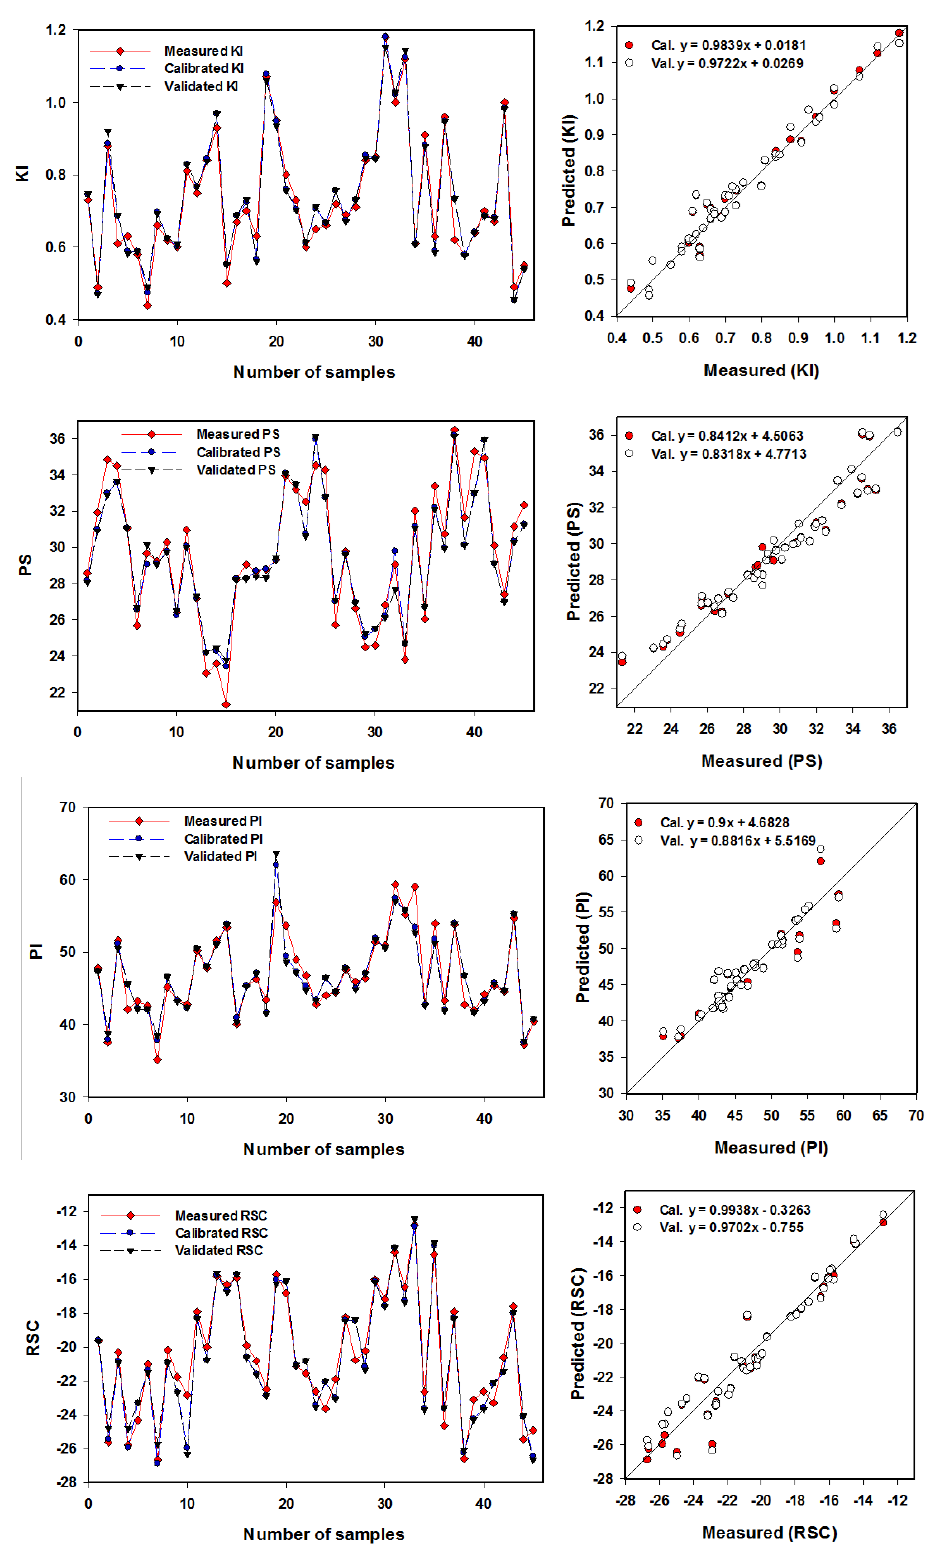
Figure 11. Relationships between the measuring, calibration, and validating datasets of the output (KI, PS, PI, and RSC) using the SVMR models. The results of the statistical analysis are displayed in Table 6.